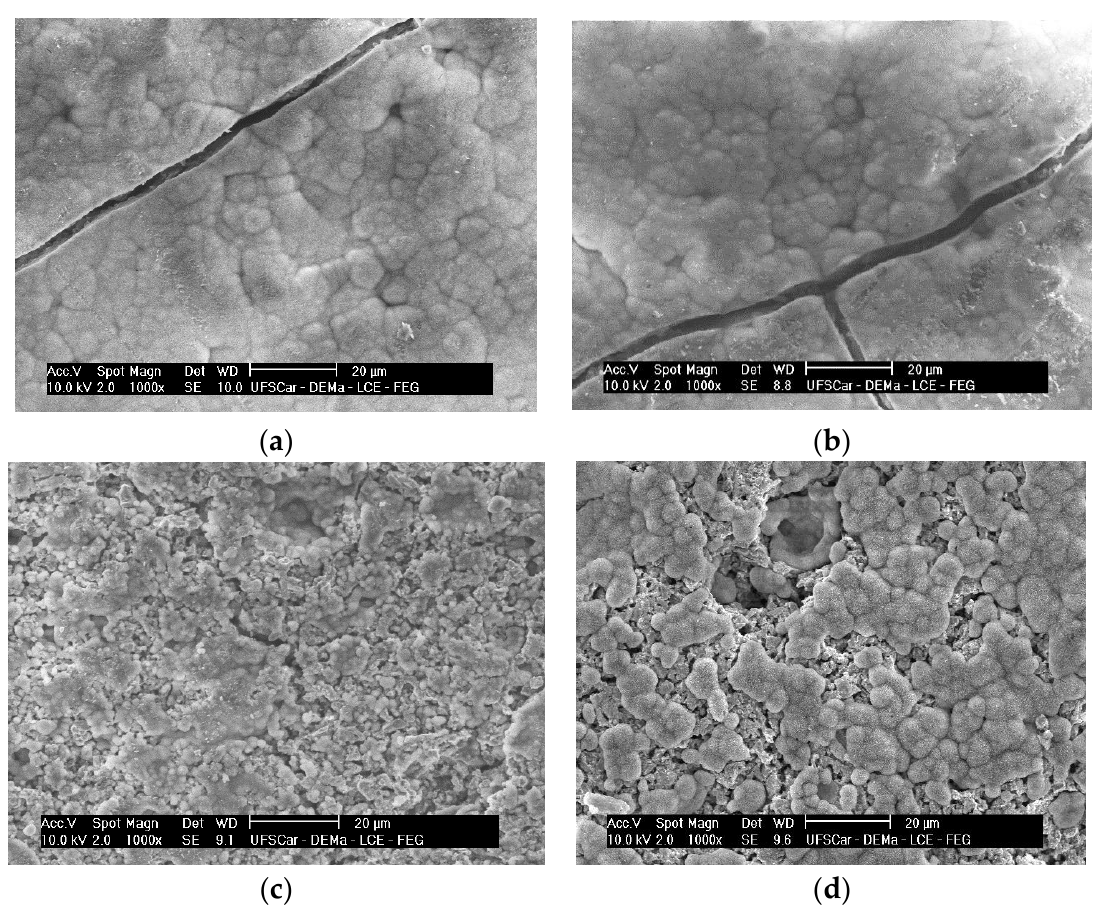
Figure 17. SEM images of the composites after SBF soaking by 7 days ( a ) LSM5, ( b ) LSM10, ( c ) LSM20 and 15 days for ( d )